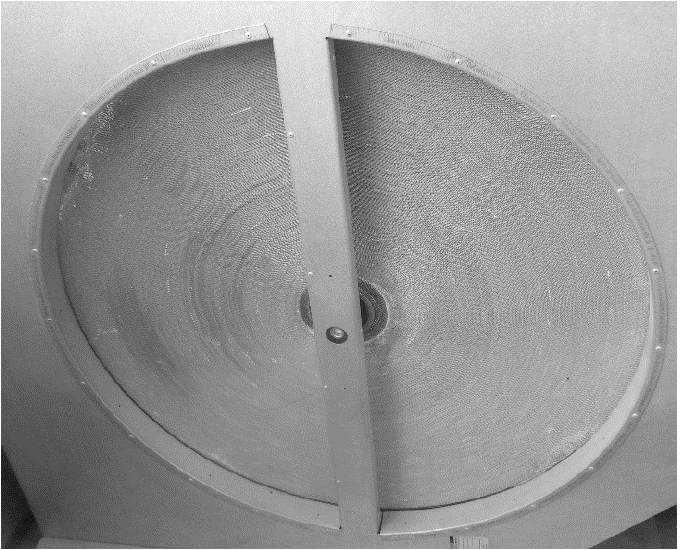
Figure 9. Rotor axial view outside the housing.